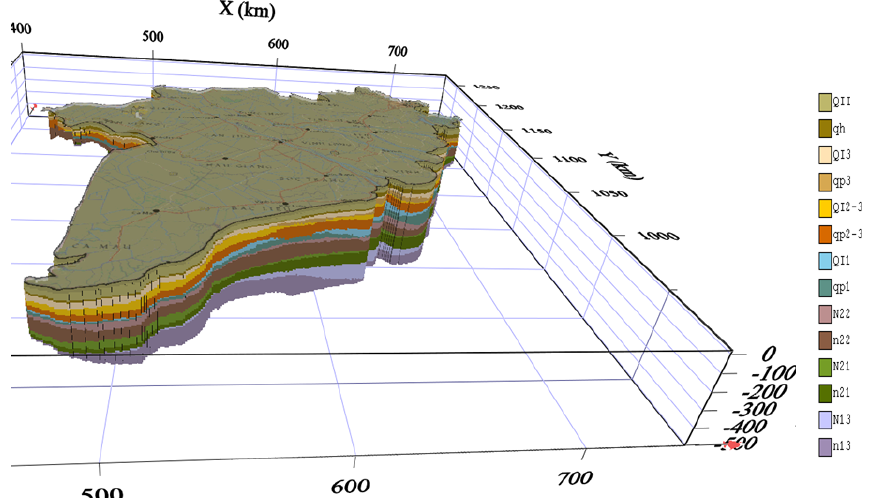
Figure 8. Updated hydrogeological block model. Scale according to kilometre reading along the axis (km) and depth in metres. Vertical exaggeration: 100 ×